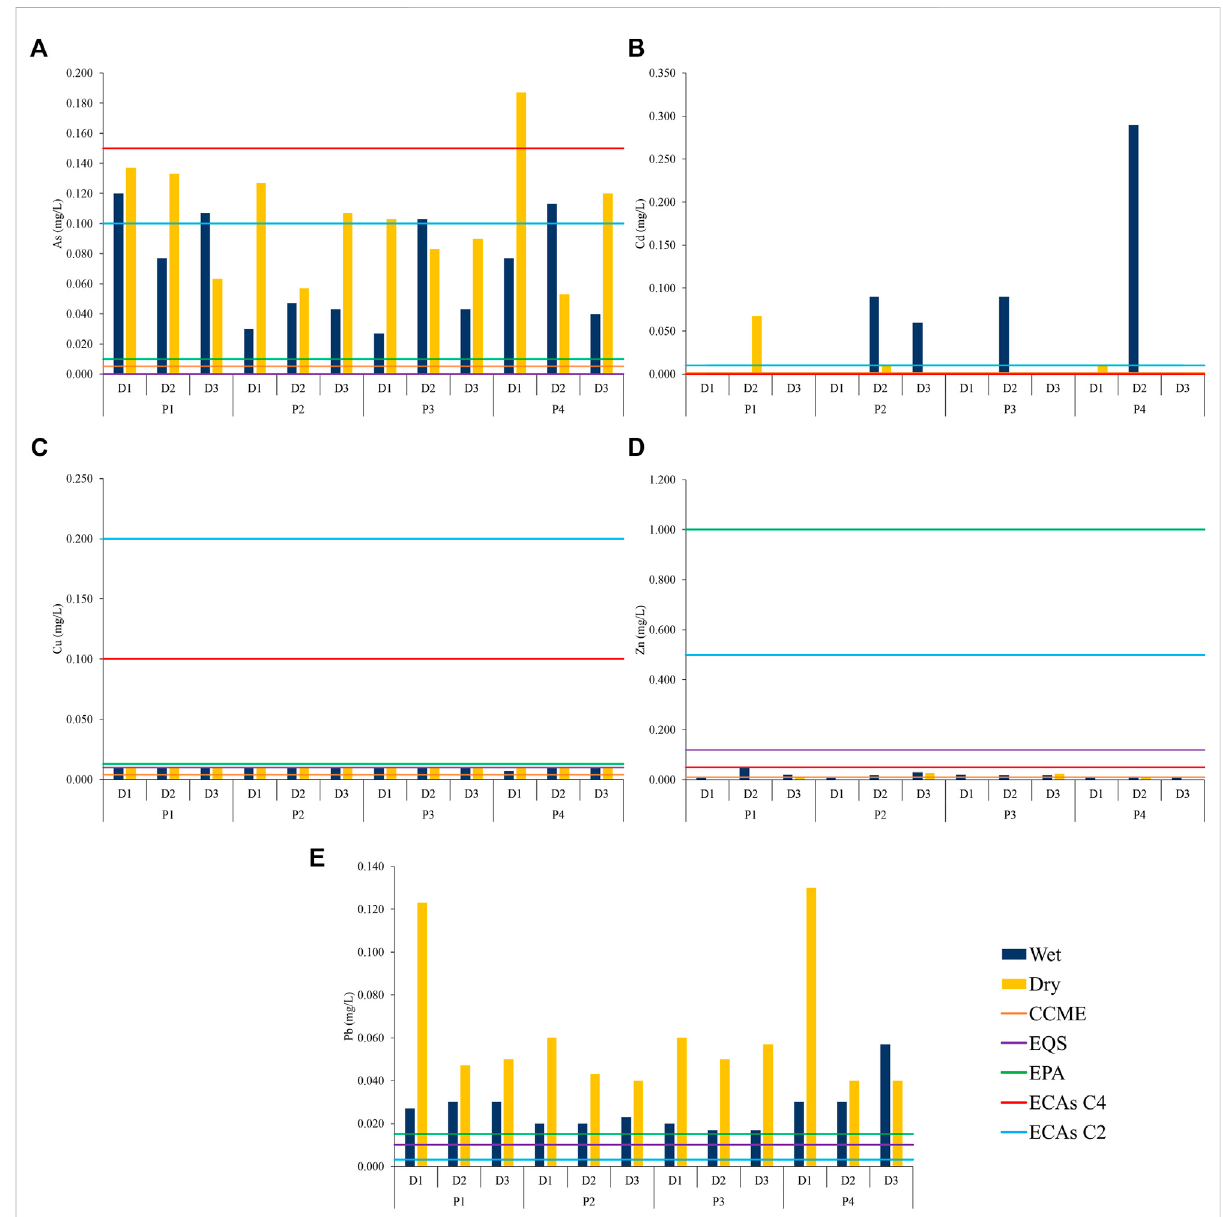
Concentration of metals and metalloids in the water and its contrast with international standards and the Peruvian standard. Arsenic (A) , cadmium (B) , copper (C) , zinc (D) , and lead (E) . (CCME: Canadian standard set by the ministers of the environment for the protection of aquatic life (CCME, 2007); EQS: international standards established by the European Union for environmental quality in the fi eld of water policy (EU, 2008); USEPA:NationalPrimaryDrinkingWaterRegulations(EPA,2009);ECAsC2andC4:NationalEnvironmentalWaterQualityStandardsofPeru,for thecategoryofconservationoftheaquaticenvironmentandthecategoryofextractionandcultivationofhydrobiologicalspeciesinlakesorlagoons (MINAM,